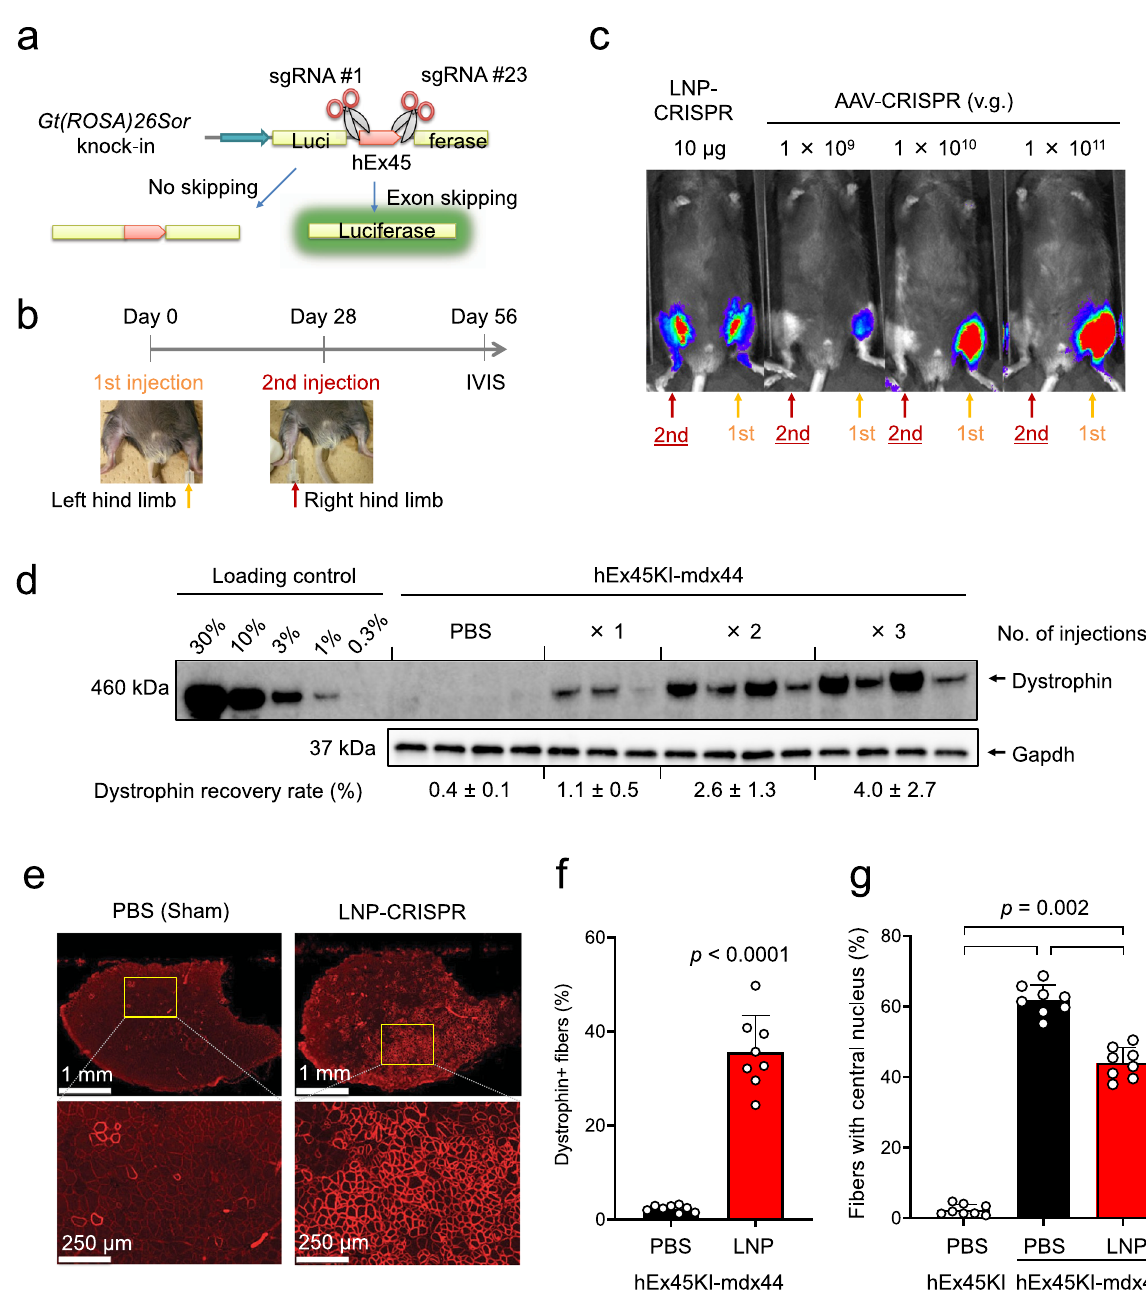
Fig. 5 LNP-Cas9/sgRNA delivery enables repeated administrations and persistent recovery of dystrophin protein. a Schematic illustration of the detection of exon skipping ef fi cacy in CAG-Luc2 hDMDEx45 KI reporter mice. Luciferase expression can be detected only if human dystrophin exon 45 skipping occurs. b LNP-CRISPR (5 μ g of each sgRNA and 10 µ g Cas9 mRNA) or AAV-CRISPR (1 × 10 9 , 1 × 10 10 , or 1 × 10 11 v.g.) was injected into the left leg of CAG-Luc2 hDMDEx45 KI mice fi rst. Then after 28 days, LNP-CRISPR or AAV-CRISPR was injected into the right leg of the same mice at the same dose as the fi rst injection. Another 28 days later, exon skipping was detected as luciferase activity by IVIS. c Representative bioluminescence images of CAG-Luc2 hDMDEx45 KI mice. LNP-CRISPR successfully induced exon skipping in the right leg after the secondary injection, whereas AAV-CRISPR failed to induce. d Administration frequency-dependent dystrophin recovery in TA one week after one, two, or three intramuscular injections of LNP with one- month intervals in hEx45KI-mdx44 mice. Data are represented as means ± S.D. ( n = 3 mice for one injection group, n = 4 mice for other groups). e Immunohistochemical staining of dystrophin 8 weeks after 6 injections of LNP-CRISPR (5 µ g of each sgRNA and 10 µ g Cas9 mRNA, 6 shots in 2 weeks). Representative images in each group of 8 mice are shown. f Percentage of dystrophin positive fi bers in TA. Data are represented as means ± S.D. ( n = 8 mice). p values by two-sided Aspin – Welch ’ s t -test showed signi fi cantly different from hEx45KI mice. g Percentage of fi bers with a central nucleus in TA. Data are represented as means± S.D. ( n = 8 mice). A signi fi cant difference was found among the three groups (two-sided Steel-Dwass